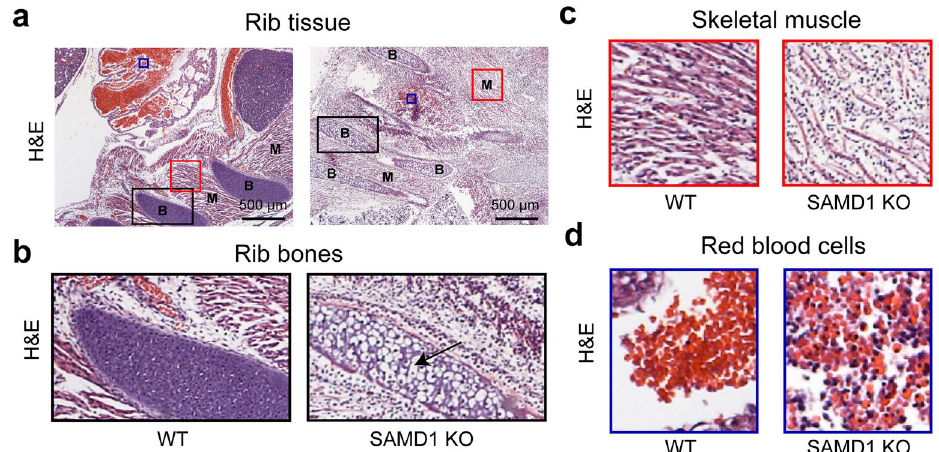
Figure 6. The absence of SAMD1 led to early bone ossification, muscle degradation, and the enduring presence of nucleated RBCs. ( a ) Macroscale microscopy of embryonic rib tissue using H&E staining at E14.5. B bone, M muscle. ( b ) Higher magnification of the rib bones, showing cartilage primordium (purple) in the wild-type mice and ossification (bubbly, indicated by the arrow) in the KO mice. ( c ) Higher magnification of the skeletal muscles shows separated and fainter muscle fibers (pink) in the KO and more unstained tissue. ( d ) Higher magnification of H&E staining of red blood cell pools from WT and SAMD1 KO embryos at E14.5 shows nucleated RBCs and immune cells in the